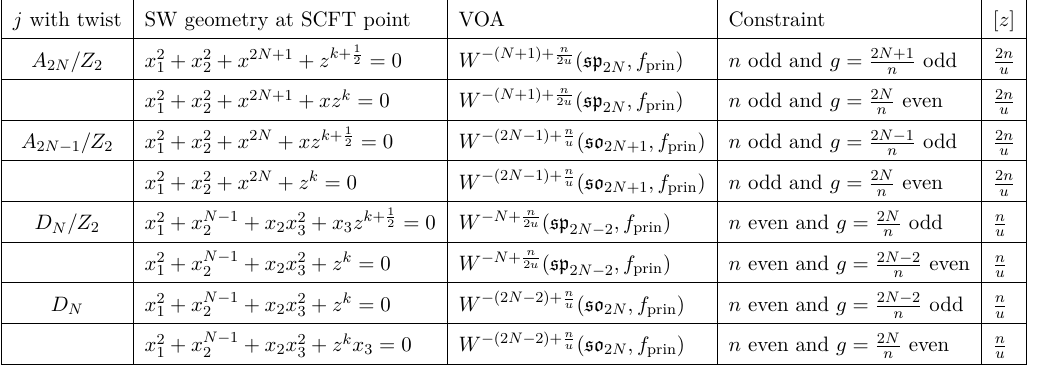
Table 13 . 4d N = 2 SCFTs whose 2d VOA is non-admissible lisse W-algebra defined using classical Lie algebra. u is an odd integer coprime with n